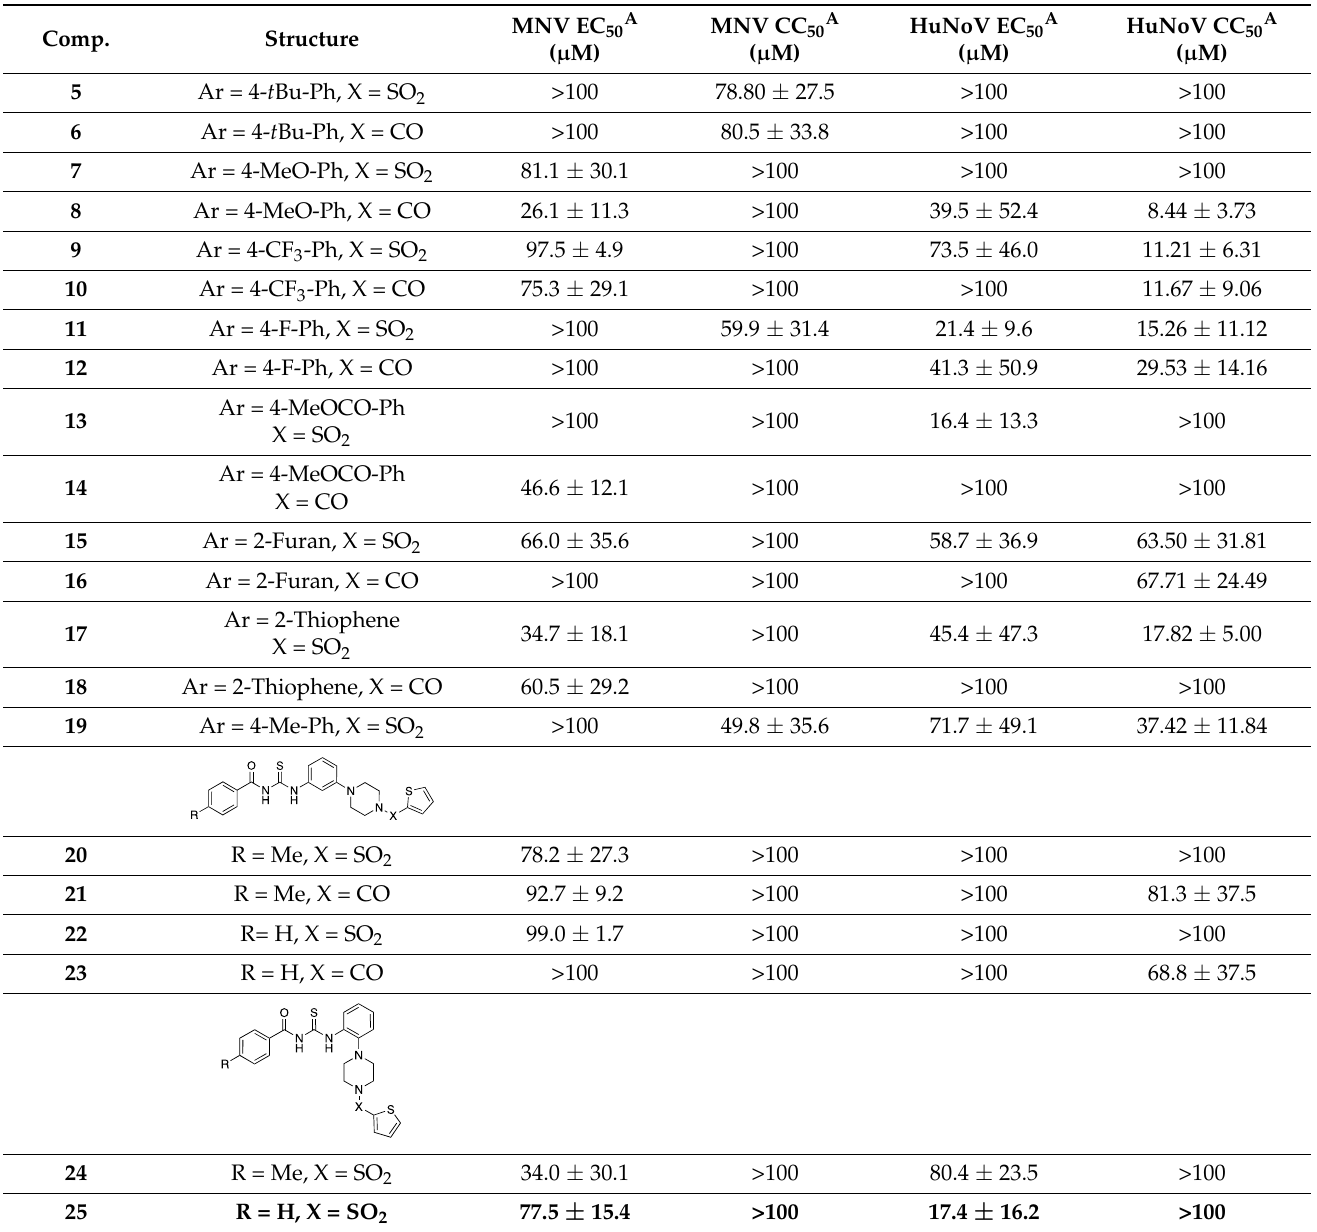
Table 1. Antiviral (MNV CPE and HuNoV GI replicon) and cytotoxicity data for the novel analogues 5–34. Results ob ‐ tained for hits 3–4 are also included.